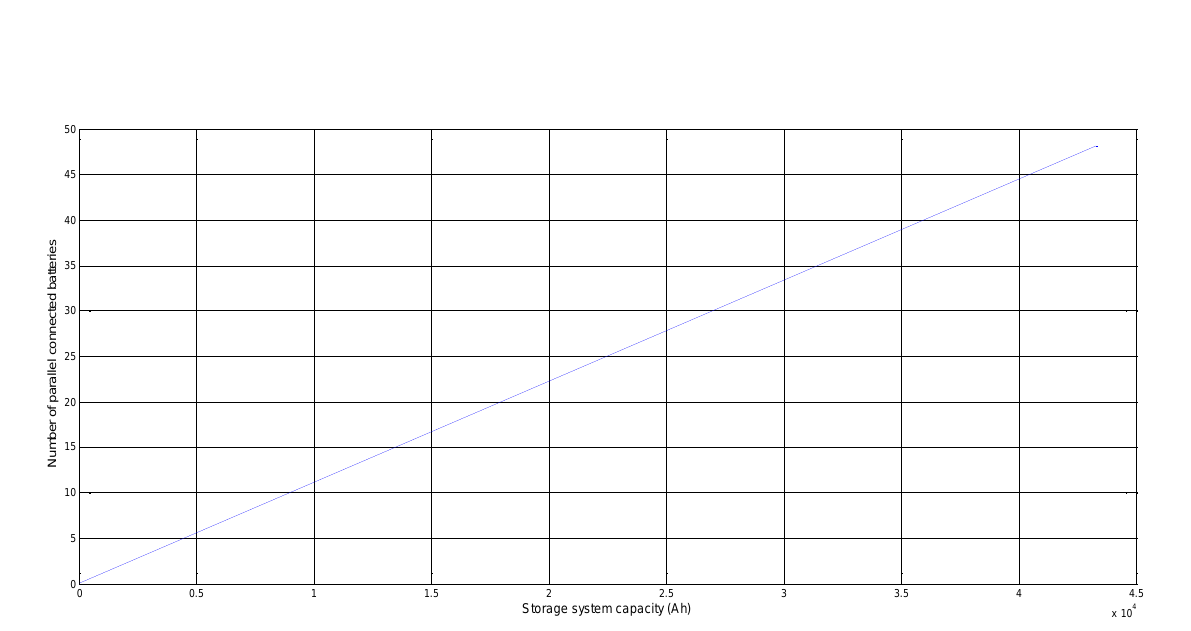
Figure 7 . Variation of number of parallel connected batteries versus total storage system capacity obtained with intuitive method